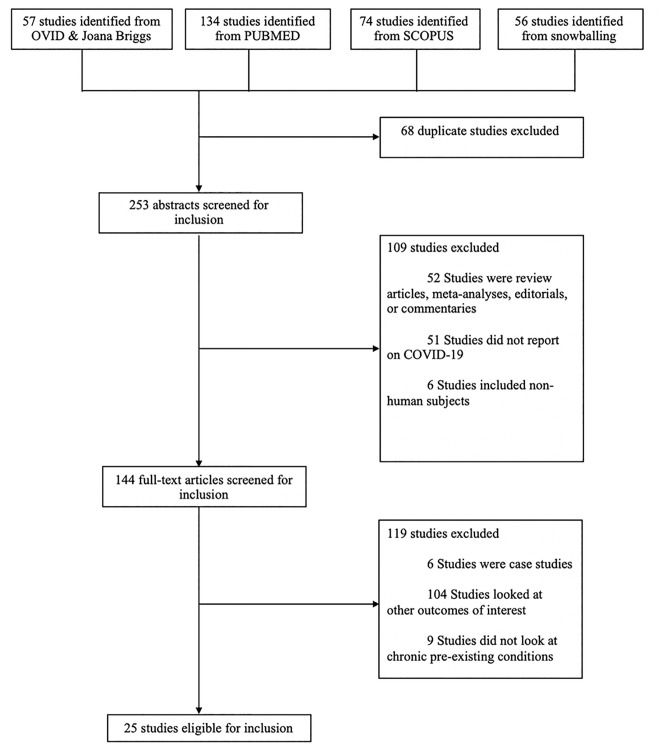
PRISMA flow diagram.